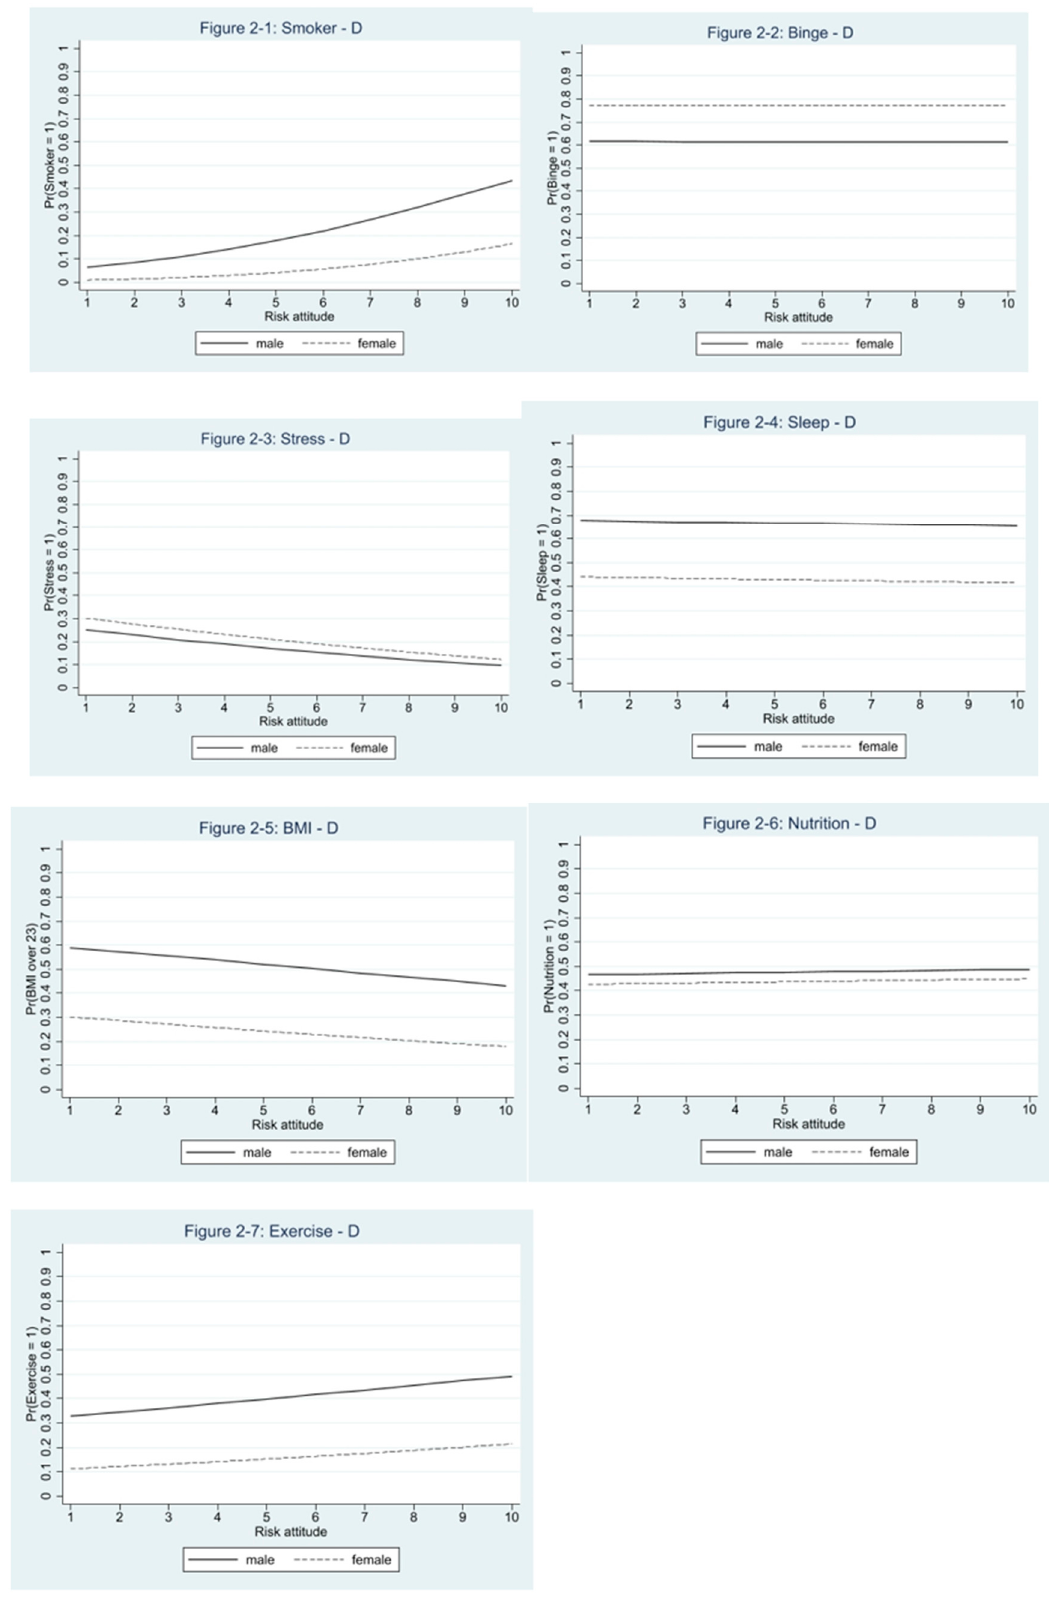
Figure 2. Plots of predicted probabilities by levels of D, for all Alameda Seven health behaviors .